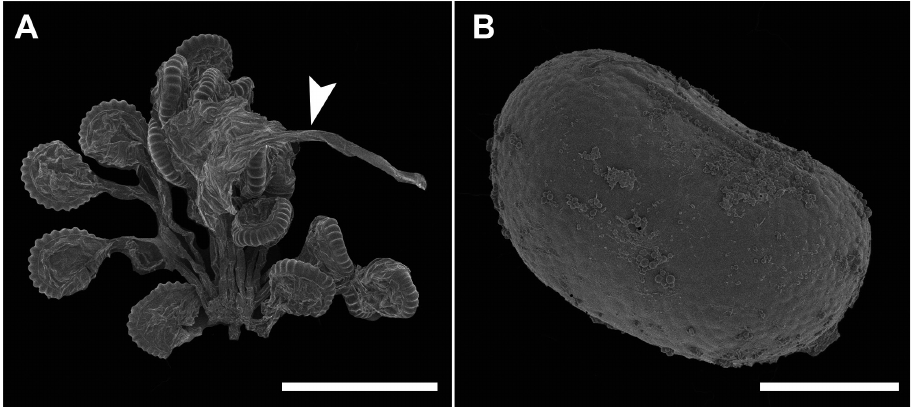
Figure 3. Adetogramma chrysolepis (Hook.) T.E.Almeida. A, B Scanning electron micrography (SEM); magnification 75× and 1750×, respectively A Sori showing sporangia and paraphysis (the latter indicated by an arrow head) B Spores. Images from Almeida & Giacomin 3121 (BHCB). Scale bars: A = 500 μm, B = 20